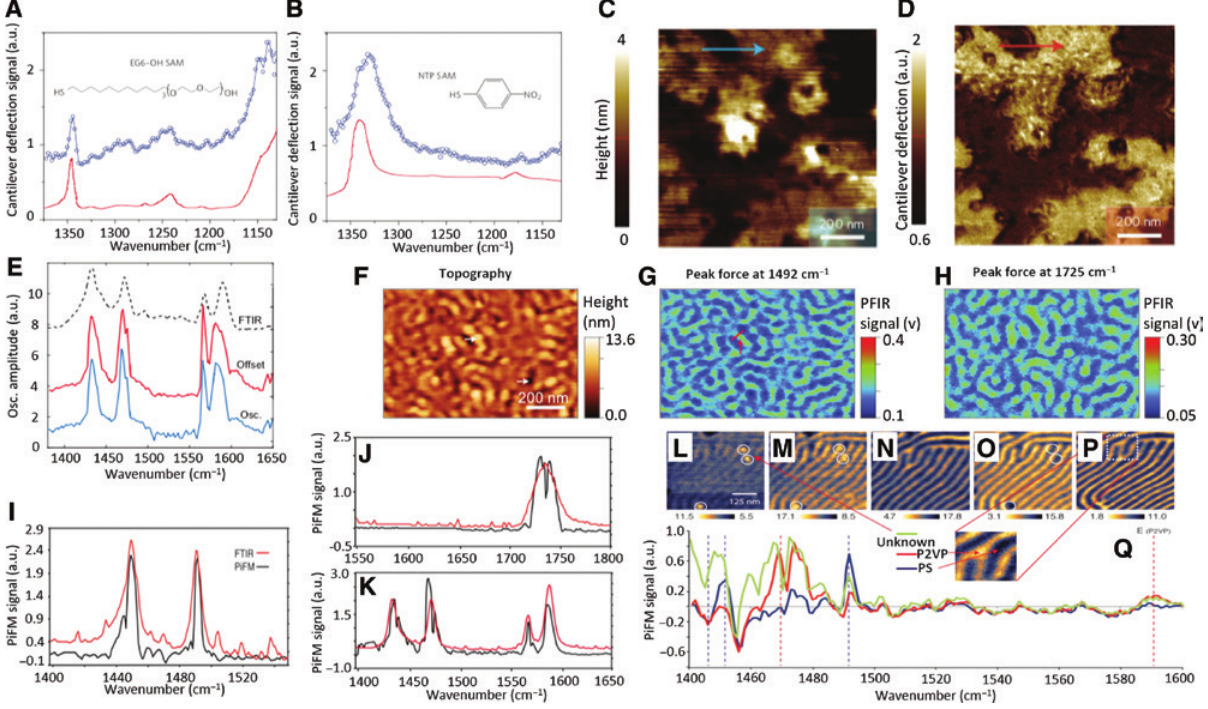
Figure 6: Chemical detection of molecular thin films [26, 55, 56]. (A, B) AFM-IR spectra (blue curve) and FTIR spectra (red curve) of self-assembled monolayer of two types of molecules ethylene glycol (EG6-OH) and 4-nitrothiophenol molecules. (C) AFM topography of monolayer of PEG molecules. (D) AFM-IR imaging of PEG molecules at 1342 cm −1 . (E) Peak-force IR(PFIR) spectra based on the oscillation amplitude of contact resonance (blue curve) and baseline offset (red curve) with FTIR spectra (dashed curve) as a reference. (F) Topography of poly(styrene-b-methyl methacrylate (PS-b-PMMA) block copolymer. (G) PFIR image at the IR frequency of 1725 cm −1 . (H) PFIR image at the IR frequency of 1725 cm −1 . (I–K) PiFM spectra (black curve) and FTIR spectra (red curve) of homopolymers polystyrene (PS), PMMA, and P2VP. (L–P) PiFM images of PS-b-poly(2-vinyl pyridine) (P2VP) at 1447, 1452, 1469, 1492, and 1589 cm −1 . (Q) The PiFM spectra of P2VP, PS, and an unknown material taken from the area circled in P (Figures adapted from Refs. [26, 55,